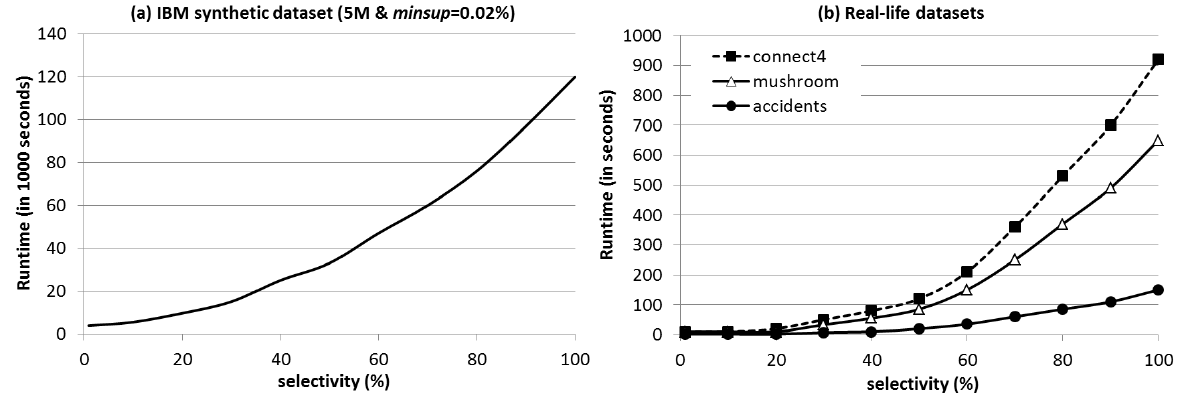
Figure 2. Runtime vs. selectivity on ( a ) synthetic dataset; and ( b ) real-life